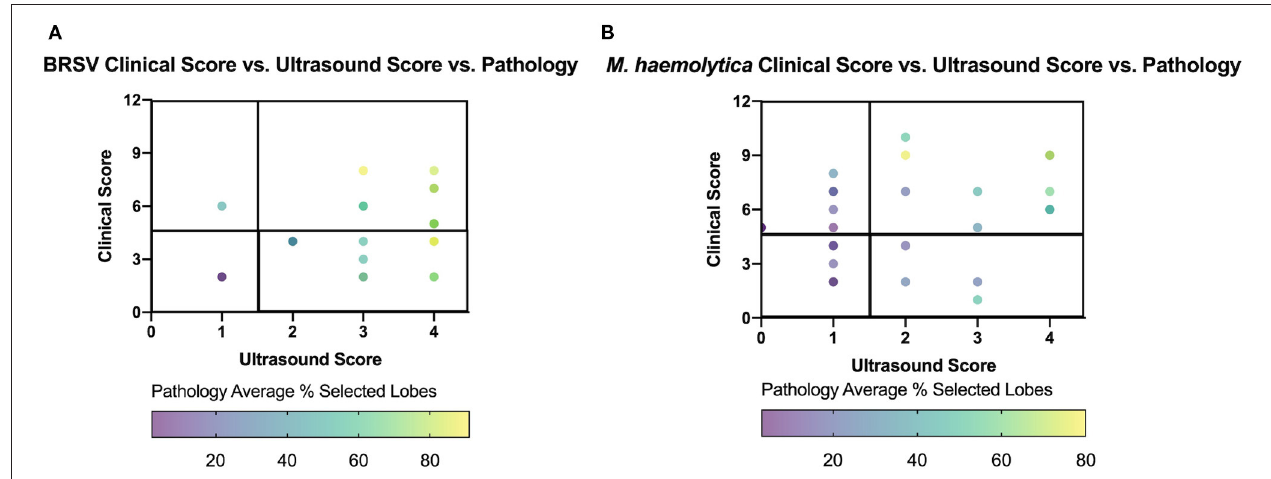
FIGURE 9 | Gross lung pathology plotted against clinical score and ultrasound score on day of necropsy for BRSV-infected (A) and M. haemolytica –infected calves (B) . Clinical score for each calf was plotted against the final ultrasound score with the color of dot representing the percentage of lung affected with gross lesions. The plot is divided into four quadrants, similar to Figure 5